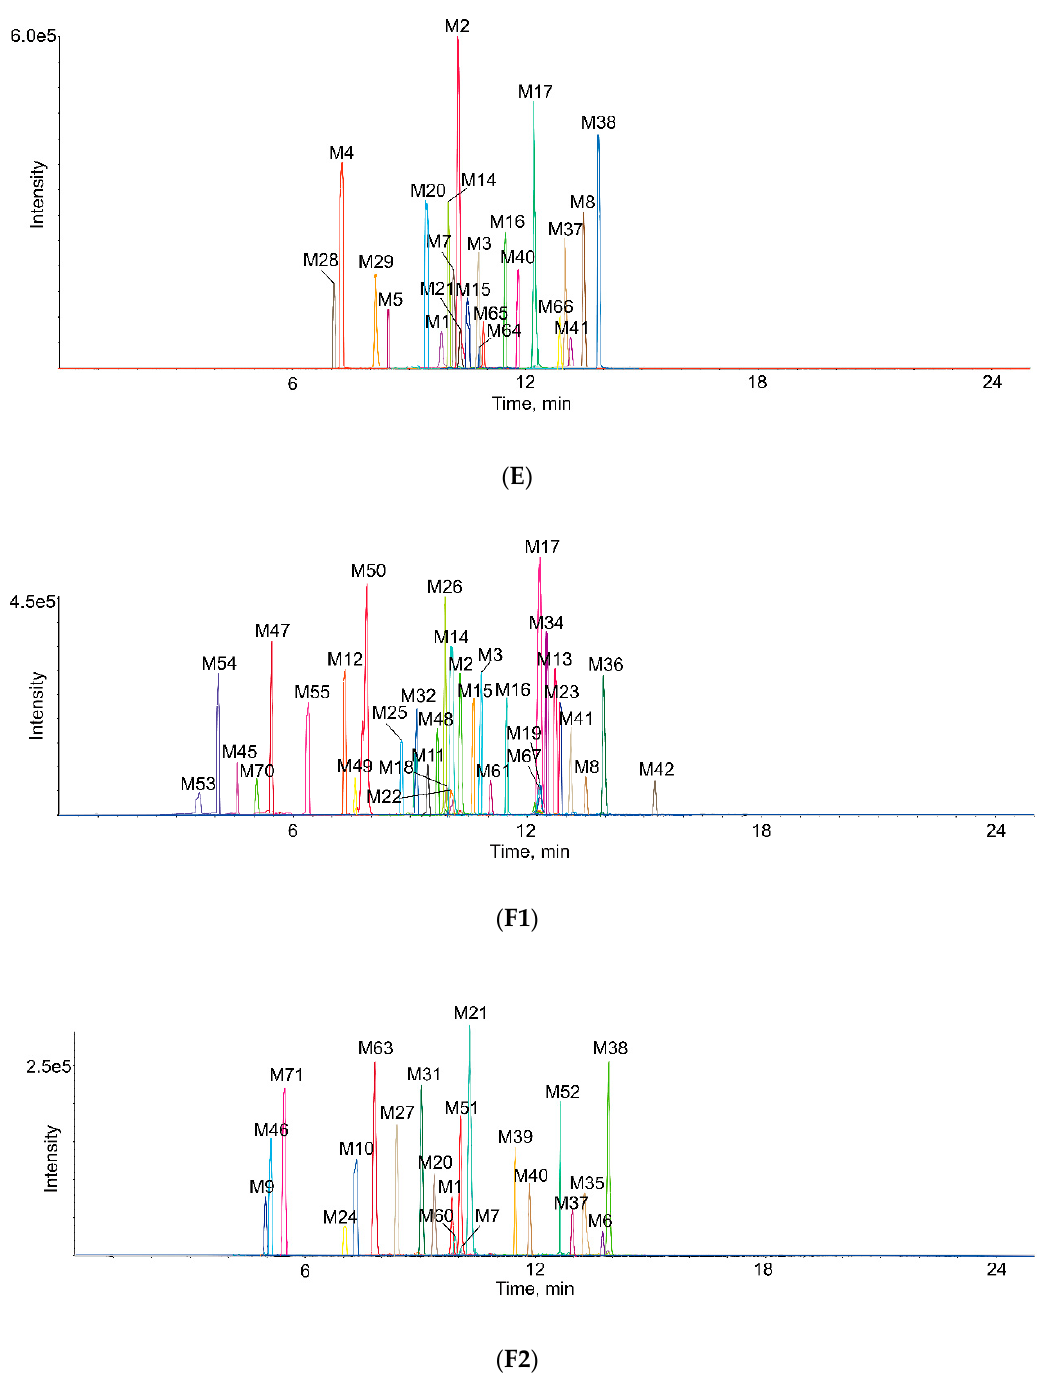
Figure 3. Extracted ion chromatograms of all metabolites of eupatorin in vivo and in vitro ( A —in rat plasma sample, B —in rat bile sample, C1 , C2 in rat urine sample, D1 , D2 in rat feces sample, E —in rat liver microsomes, F1 , F2 in rat intestinal flora).